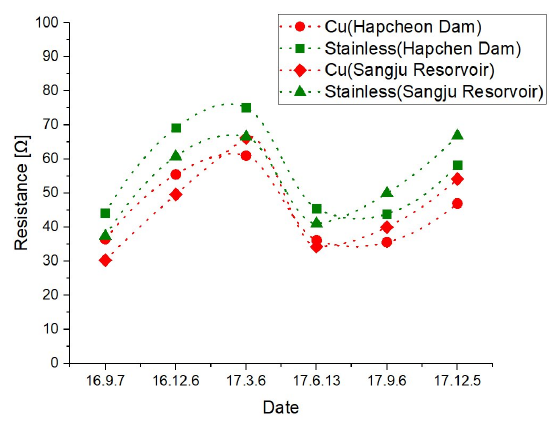
Figure 5. Variation of resistance with different